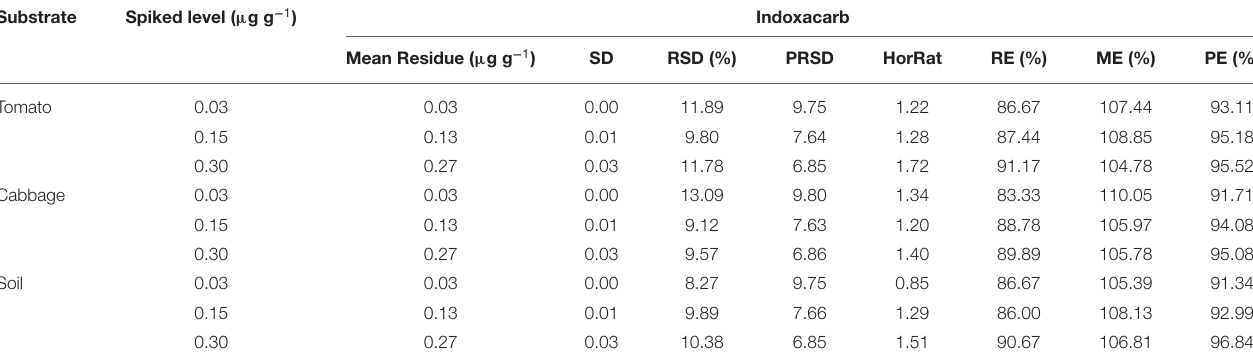
TABLE 1 | Results of method validation of